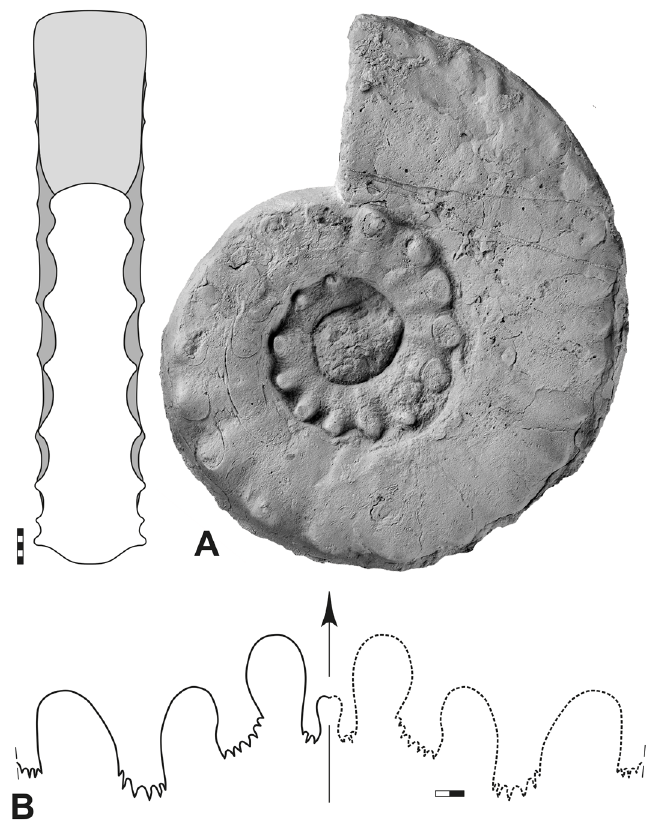
Fig. 44. Clivotirolites petilus Korn & Hairapetian gen. et sp. nov. A . Lateral and dorsal view, holotype MB.C.29962, section E, float. B . Suture line, holotype MB.C.29962, at 45.5 mm dm, 14.9 mm wh. Abbreviations: see Material and methods. Scale bar units = 1